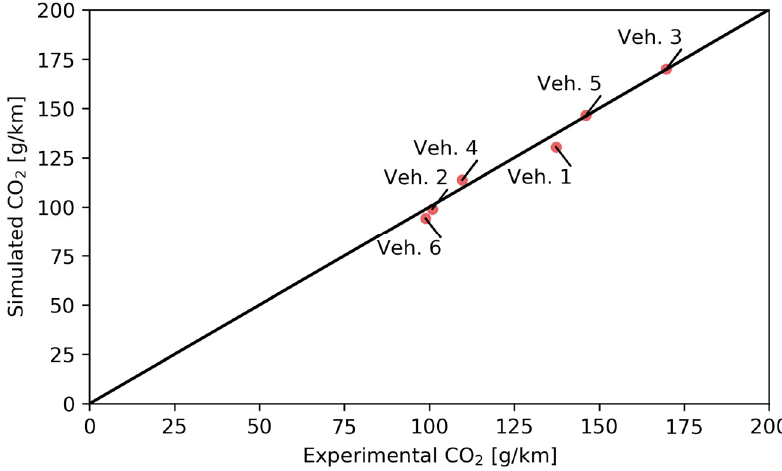
Figure 10. Comparison of absolute balanced CO 2 emissions between experimental and simulation results.